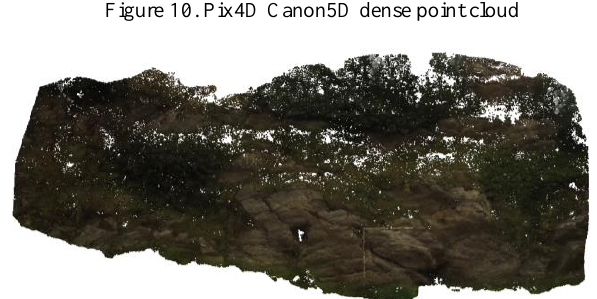
Figure 11. Pix4D GoPro dense point cloud